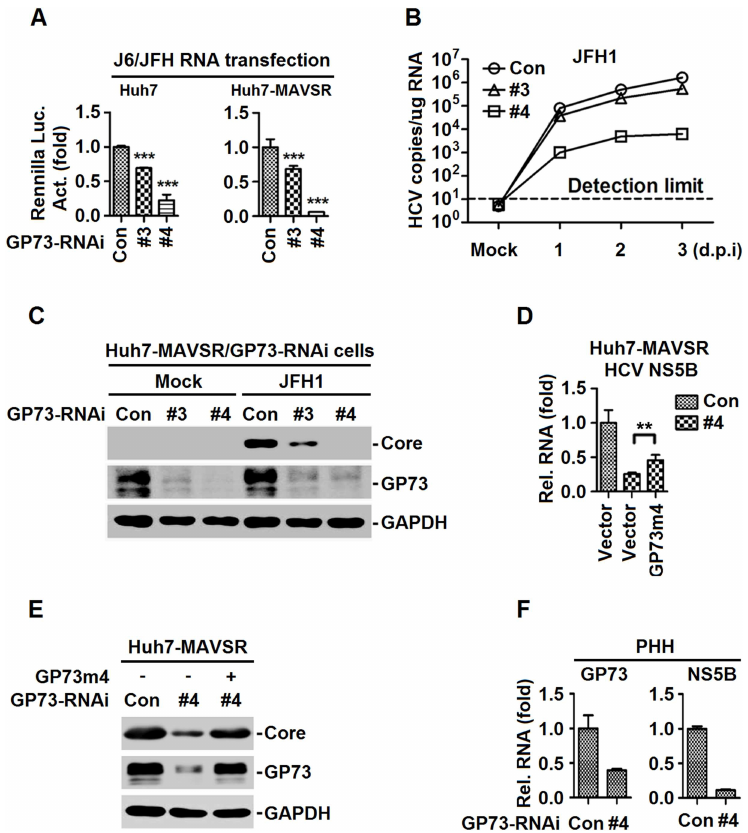
Fig 6. GP73facilitatesHCV infection and replication. ( A ) GP73 -RNAi-transduced stableHuh7or Huh7- MAVSRcells weretransfected with in vitro transcribedFL-J6/JFH5’C19Rluc2AubiRNA (J6/JFH) for 48 h, and Renilla luciferaseactivitiesweremeasured. ( B , C ) GP73 -RNAi-transduced stableHuh7-MAVSR cells wereinfectedwithHCV at MOI = 2 for indicatedtimes. IntracellularHCV RNA abundancewas determinedby qRT-PCR(B), HCV coreproteinat 3 days postinfection(d.p.i)was detectedby WB (C). ( D , E )Huh7-MAVSR- GP73-RNAi cells weretransfectedwith GP73 -rescue plasmid( GP73m4 )for 24 h, followedby HCV infectionat MOI = 2 for 3 days. HCV RNAs weredeterminedby RT-PCR(D) andHCV core proteinwasdetectedby WB (E). ( F )PHHs weretransducedwith GP73 -shRNA lentivirusfor 48 h, followedby HCV infectionat MOI = 2 for 2 days. HCV RNA levelsweredetermined by RT-PCR.Bar graphsrepresentmeans ± SD, ** P < 0.01compared with controlgroup.